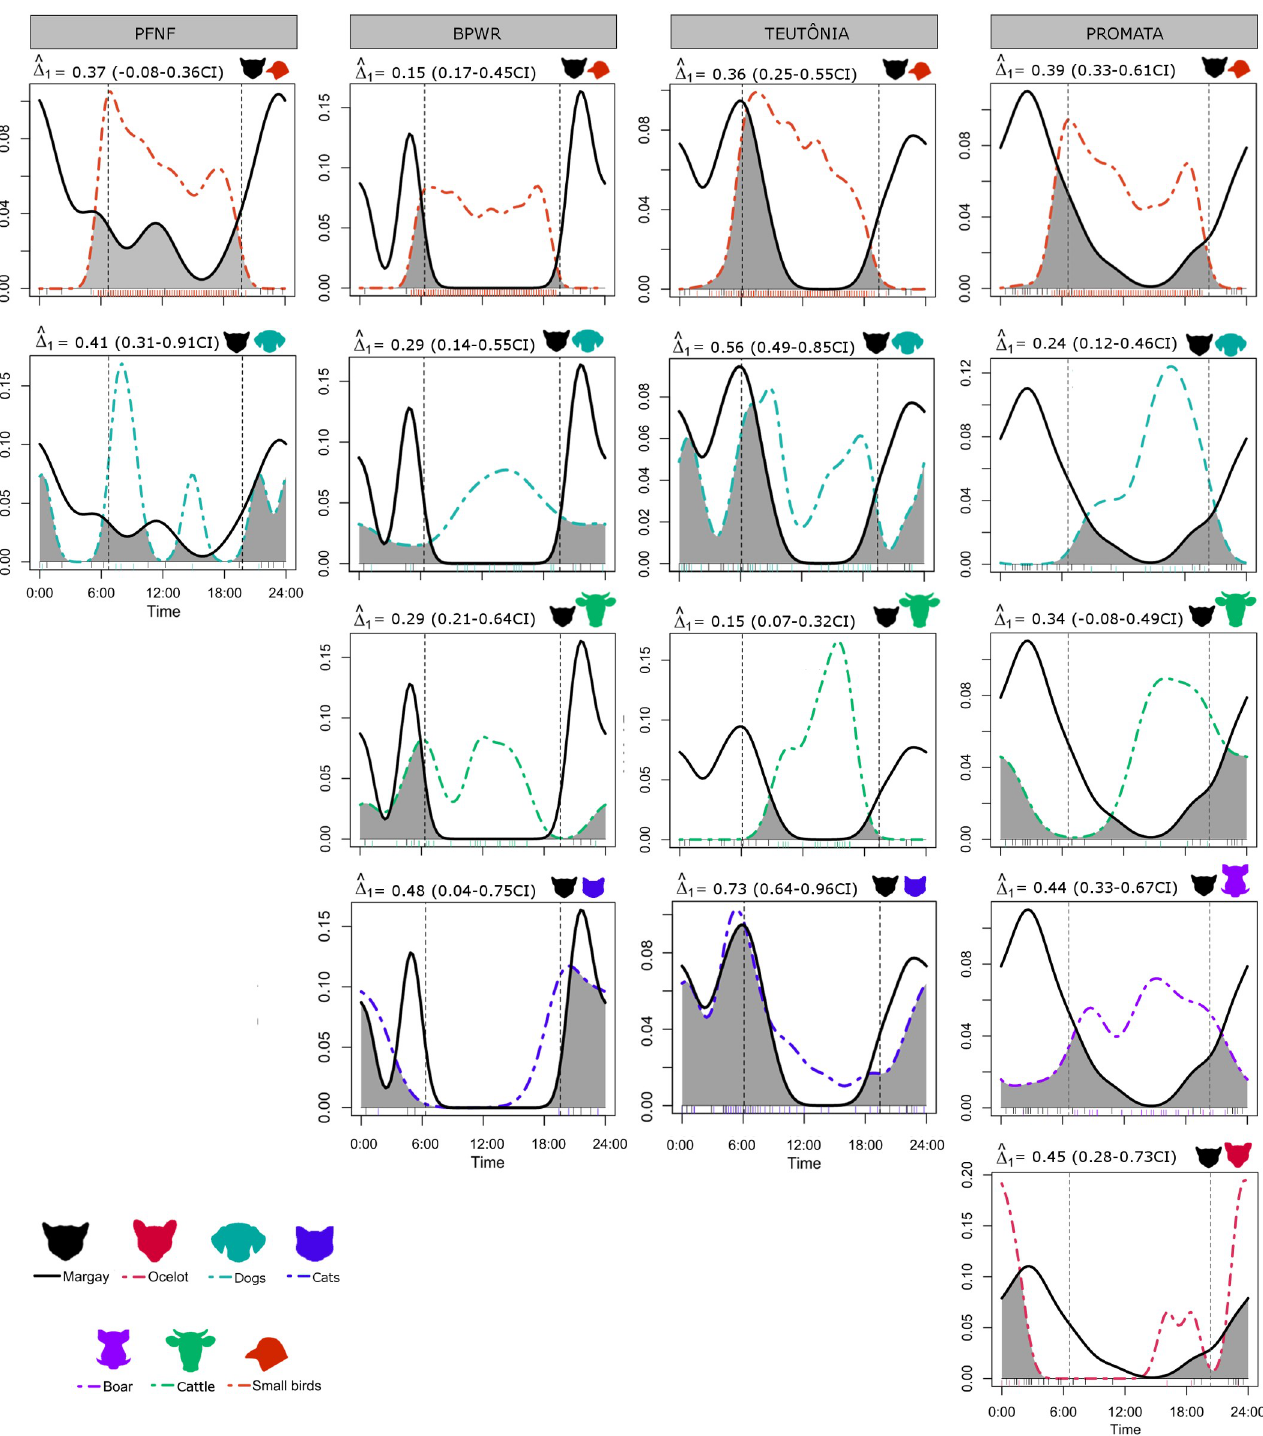
Fig 9. Activity and temporal overlap ( Δ 1 , CI) of margay and the remaining evaluated species in the study area—Ocelot, domestic dog and cat, boar, cattle and small birds. Overlap coefficient ( Δ 1 ) between species is indicated by the shaded area. The dotted grey lines represent sunset and sunrise times during the sampled period in each area (S3